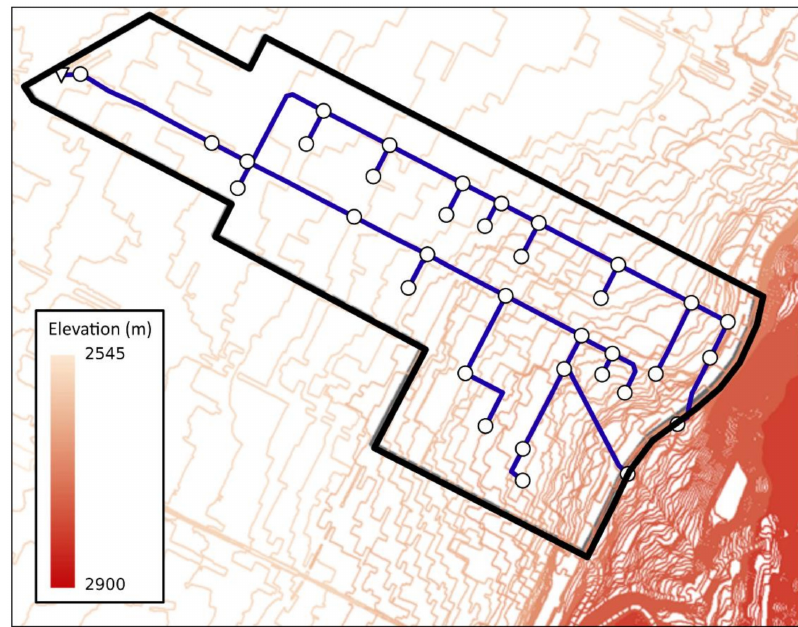
Figure 6. Digital elevation model of the area for the E-Chico